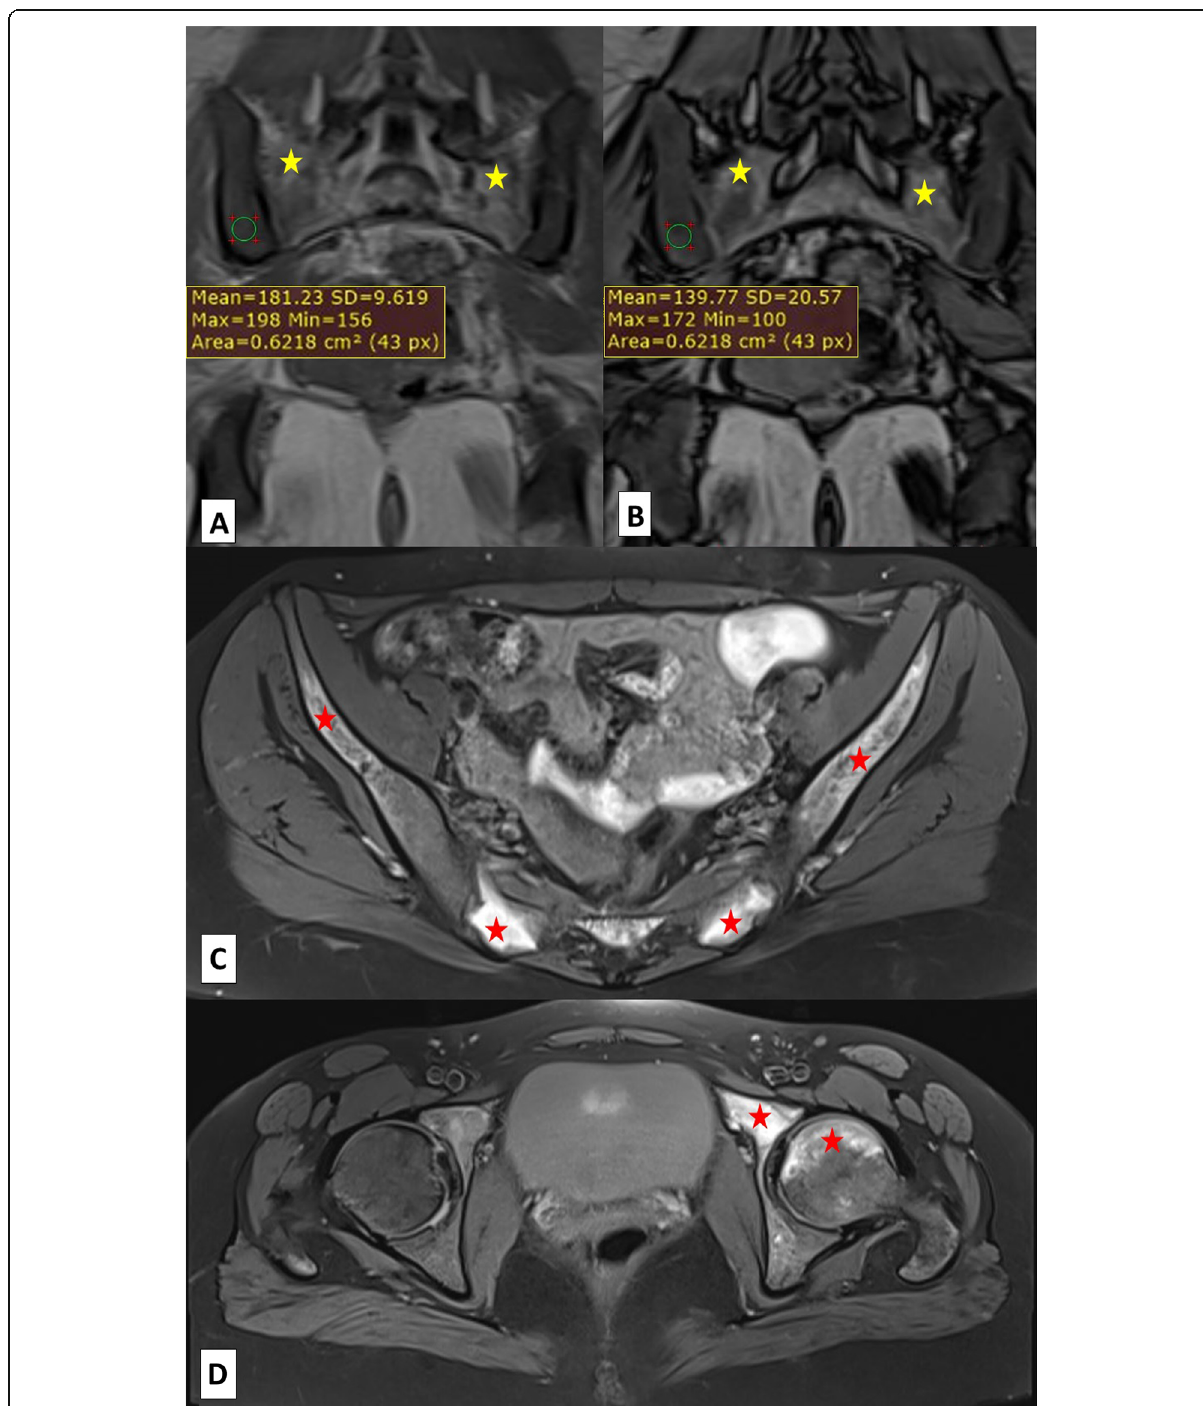
Fig. 3 Coronal IP ( a ) and OP ( b ) with axial T1fs ( c & d ) in 27 year-old female patient with bilateral acute pelvic bone pain, show diffuse persistent red marrow with normal percentage of signal loss on OP (IP-OP/IP = 23 %), note the patient had diffuse low signals on T1 (not shown). ( c & d ) show multi-focal T1 hyperintensity in the sacrum, pelvic bone, left acetabulum and left femoral head consistent with acute osteonecrosis, note corresponding sacral hyperintensity on IP and OP